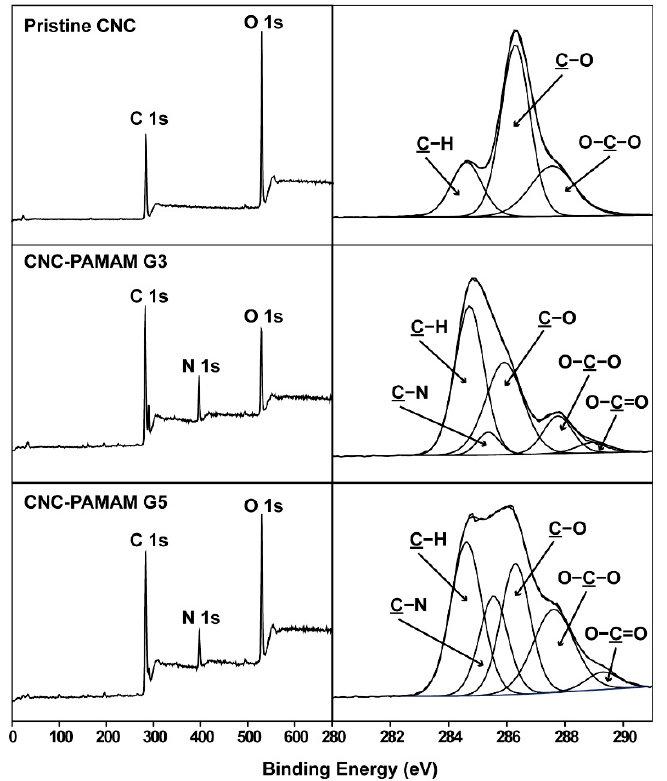
Figure 4. XPS wide-scan and C 1s core-level spectra of the pristine CNC, CNC-PAMAM G3, and CNC-PAMAM G5.